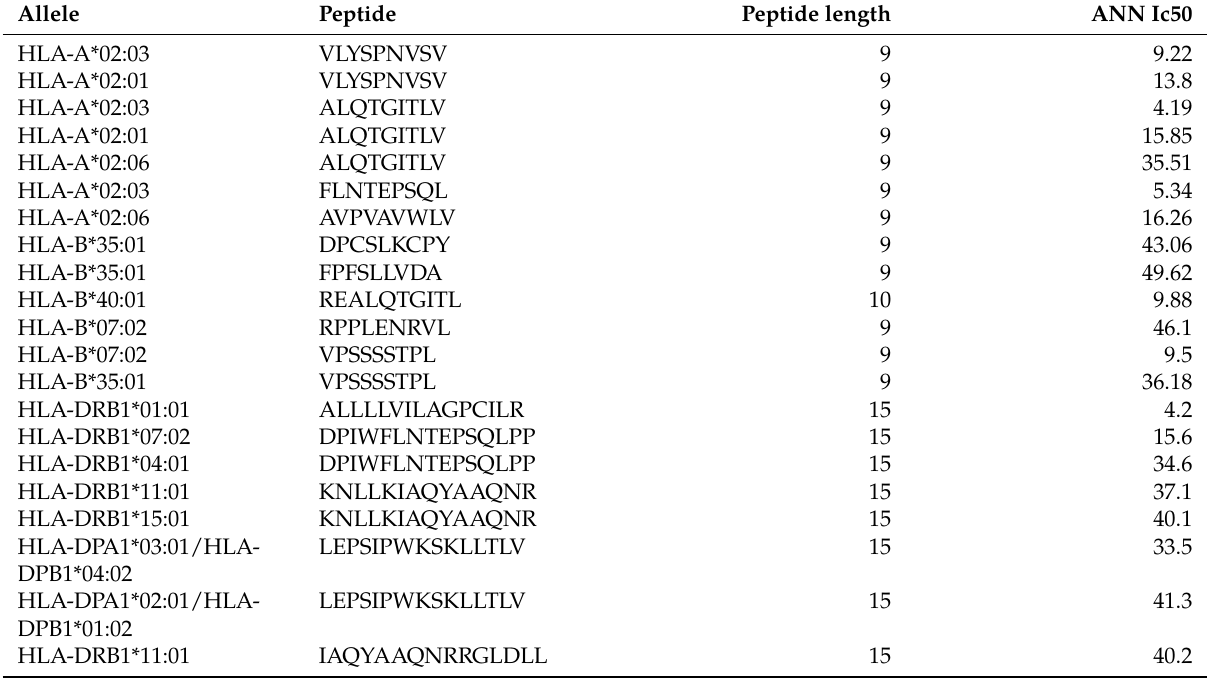
Table 3: Selected epitopes that have ANN Ic50 score below 50 and found consensus after PVS analysis. Allele Peptide Peptide length ANN